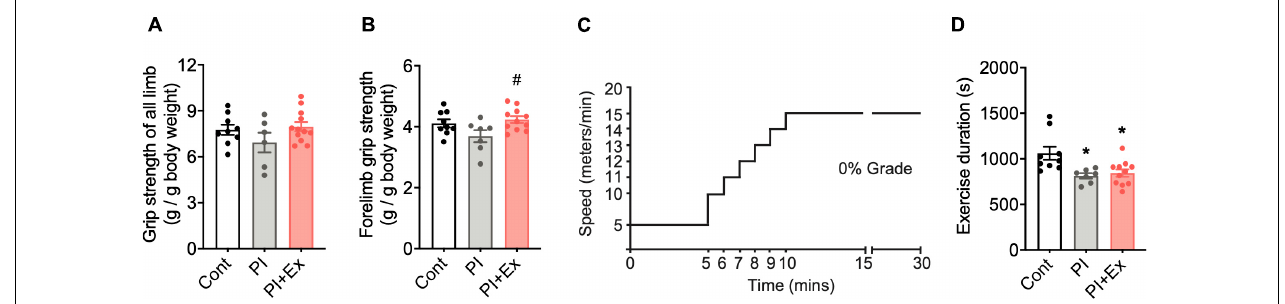
FIGURE 6 | Regular low-intensity exercise prevents decreased muscle strength due to physical inactivity housing but shows no improvement in endurance exercise capacity. (A,B) Both all-limb and forelimb grip strengths normalized to body weight. (C) Protocol of endurance exercise test. (D) Time (seconds) that mice could run for until exhaustion in endurance exercise test on the treadmill. All data are presented as the mean ± SEM (Cont mice, n = 10; PI mice, n = 7; PI + Ex mice, n = 10). Data were analyzed using one-way ANOVA with Tukey’s post-hoc test. *p < 0.05 compared with the Control mice and # p < 0.05 compared with PI